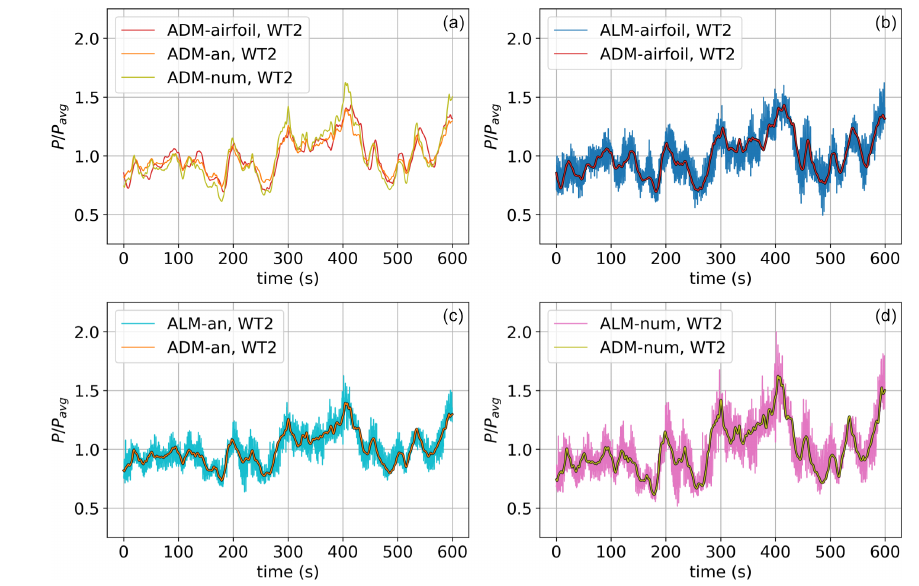
Figure 10. Model comparison of the power output time variation normalized with its time-averaged value ( P avg ) for two turbines in the ABL under average velocity inflow conditions at hub height of U ∞ = 8ms − 1 . (a) Comparison of the three ADMs. (b–d) The comparisons of the same groups of ADMs and ALMs are